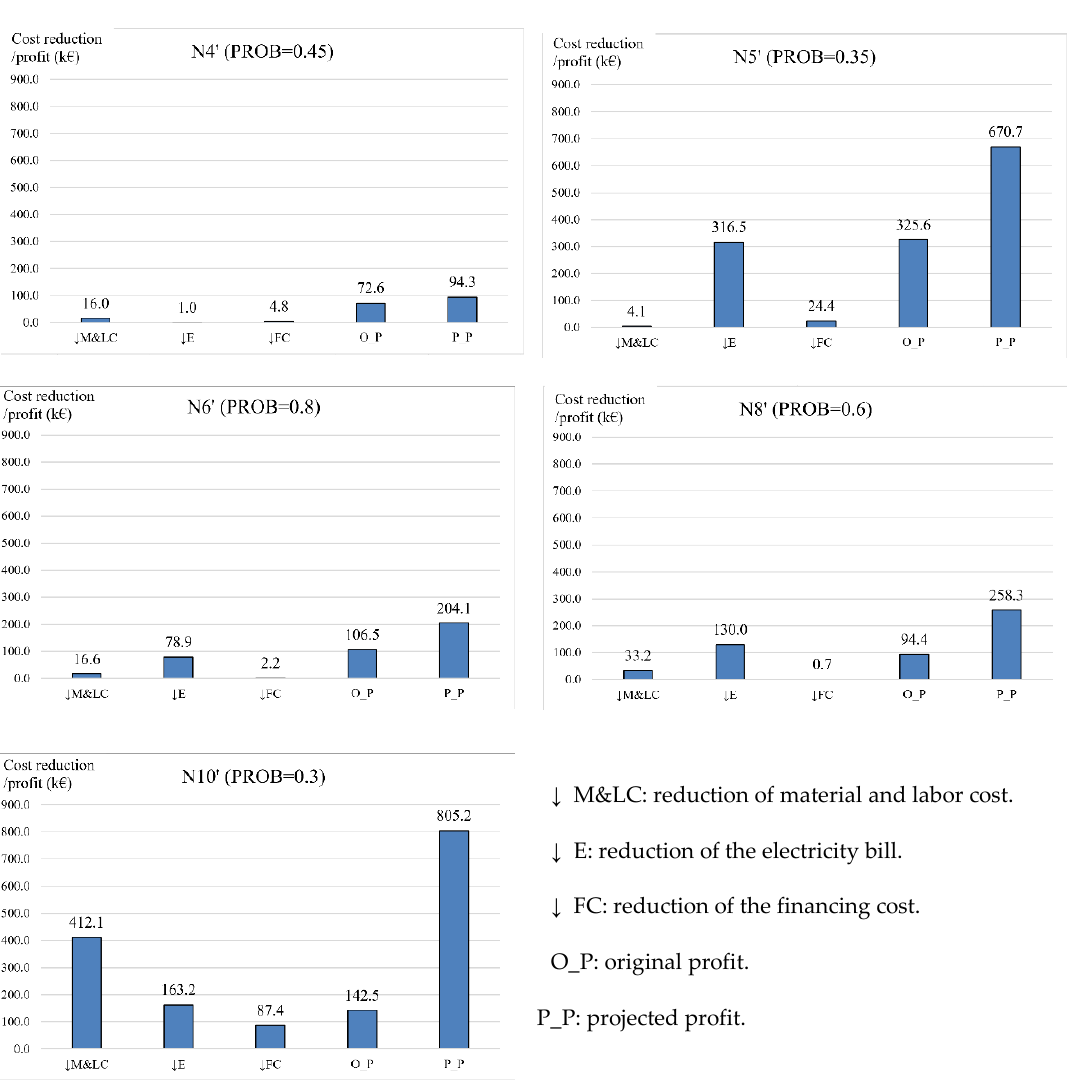
Figure 4. Input costs reductions and original and projected profit of projects selected by the proposed approach.